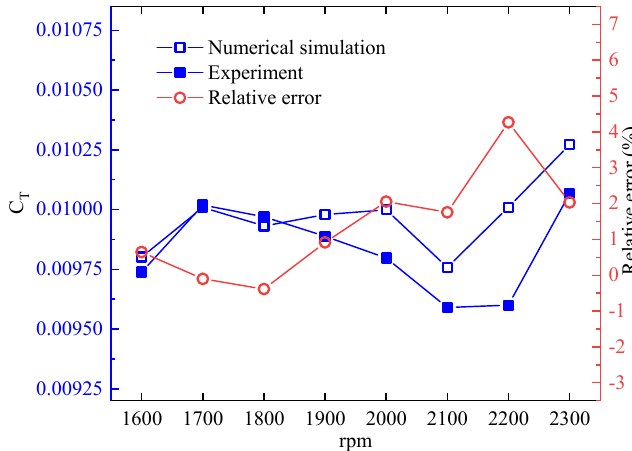
Figure 9. Comparison of thrust coefficient C T .